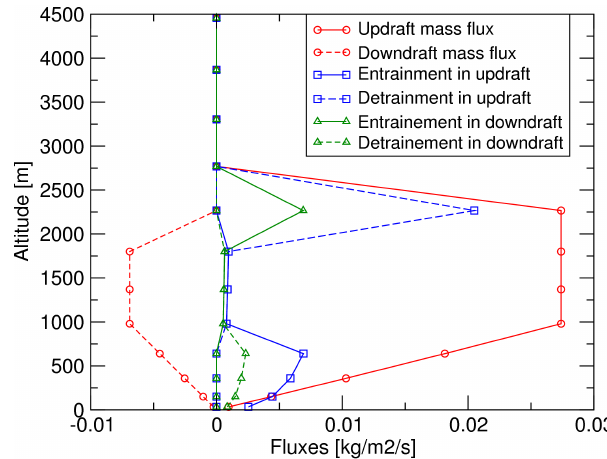
Fig. 8. Entrainment and detrainment fluxes in the updrafts and downdrafts.